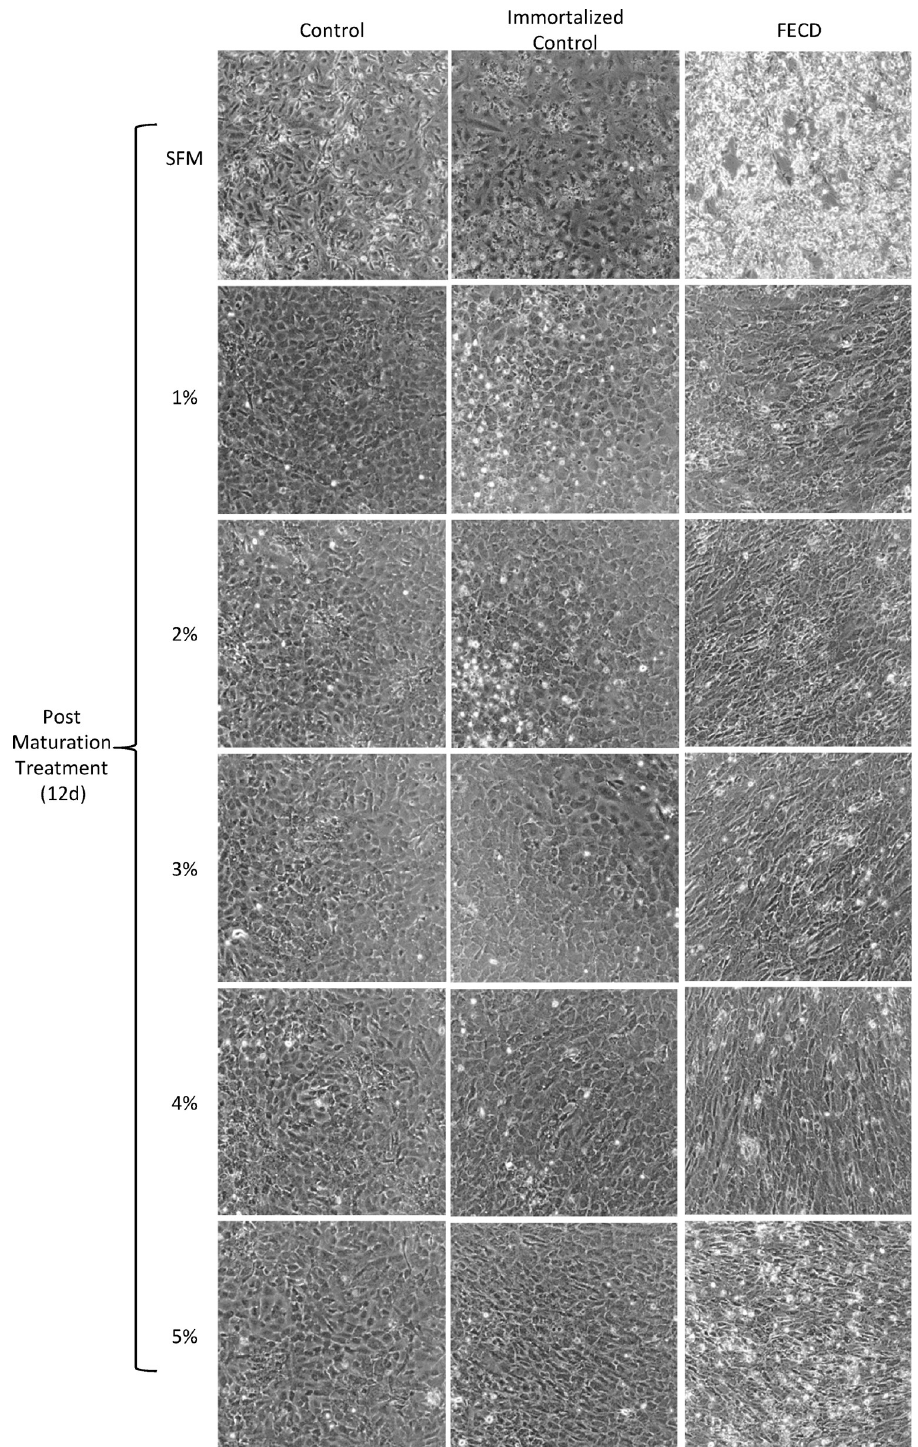
Fig 4. Morphology of normal, immortalized, and FECD-HCECs after maturation with different concentrations of FBS. Representative images of confluent HCECs following proliferation in Joyce’s medium and maturation in human endothelial-SFM supplemented with 0–5% FBS. HCECs from a 9 year old male donor (Norm6) with no corneal disease are on the left, HCECs from same donor after hTERT immortalization are center, and FECD-HCECs are on the